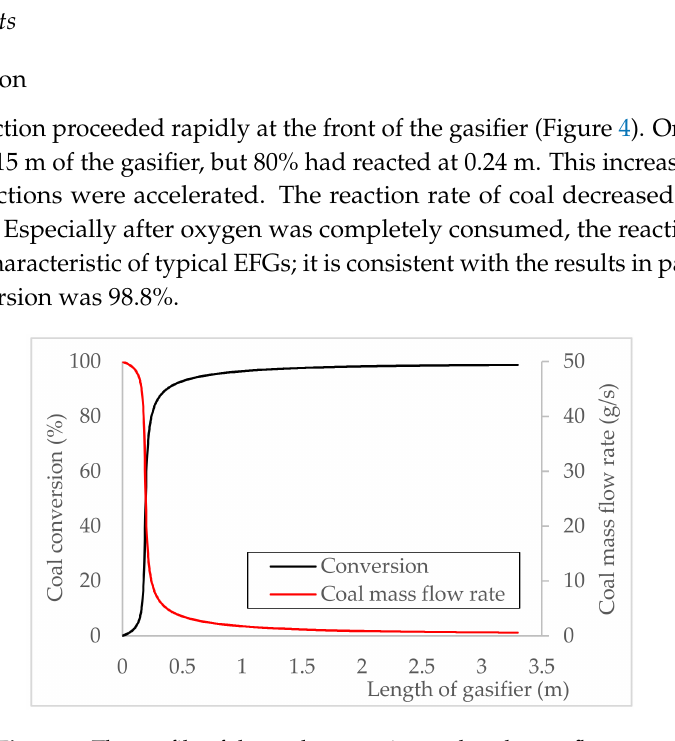
Figure 4. The profile of the coal conversion and coal mass flow rate.